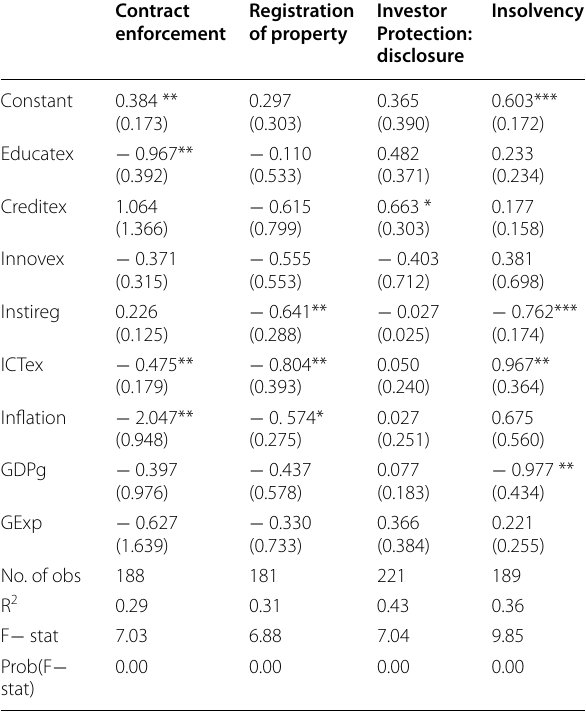
The estimated coefficients are given in the table followed by the standard errors in parenthesis. ***, **, * indicates the level of significance at the 1%, 5%,